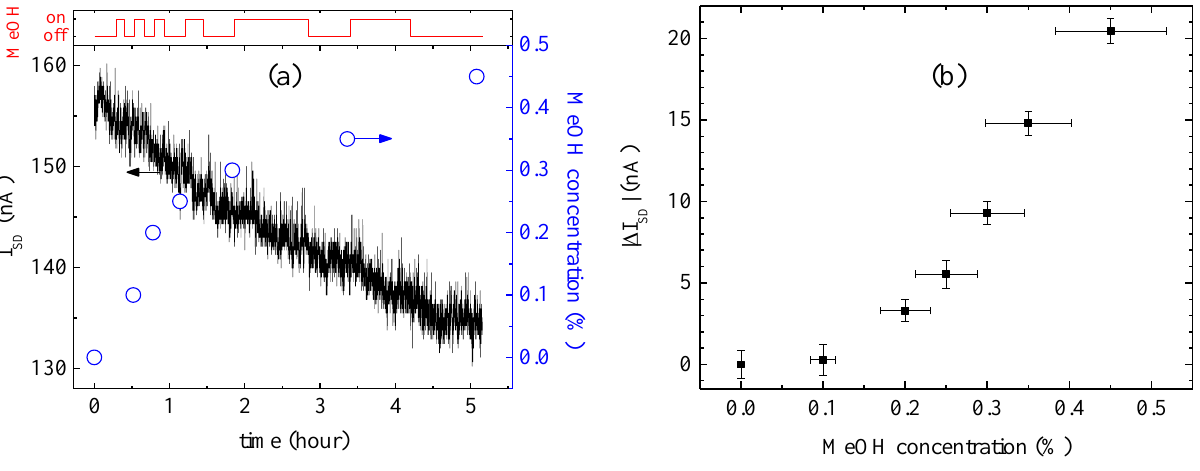
Figure 7. Methanol vapor detection with the SAPC and the CNT sensor in the actual field test using a cotton bud moistened with the methanol solution (the first peak for 0.25 % and the second peak for 0.15 % methanol vapor concentration indicated by the